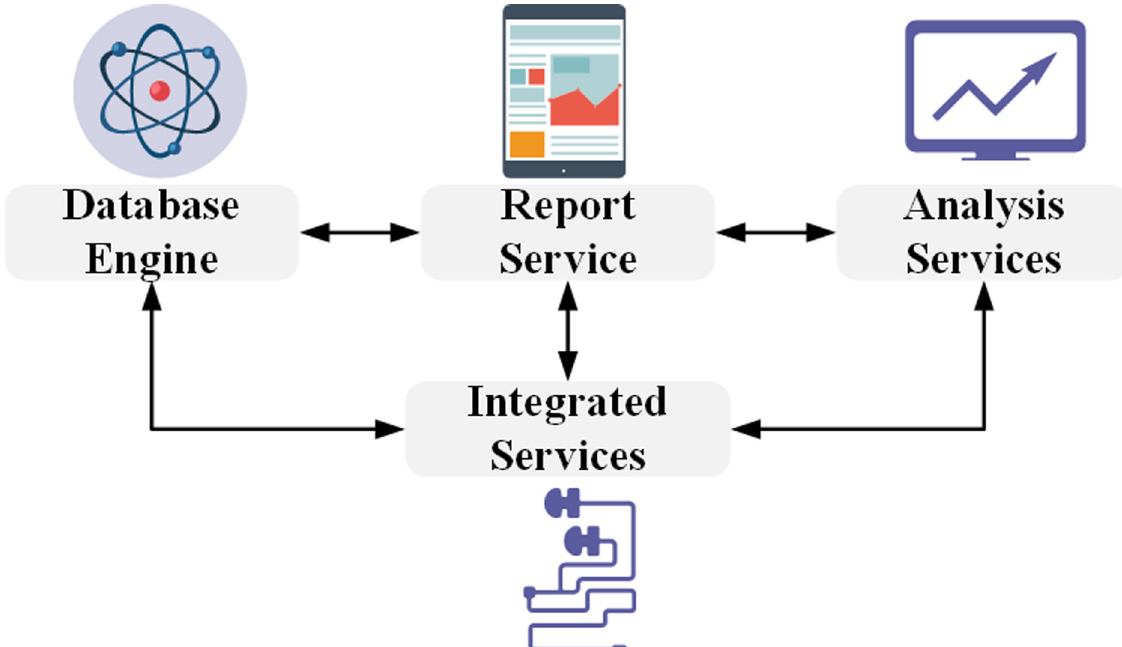
Fig 8. Architecture of Microsoft SQL Server